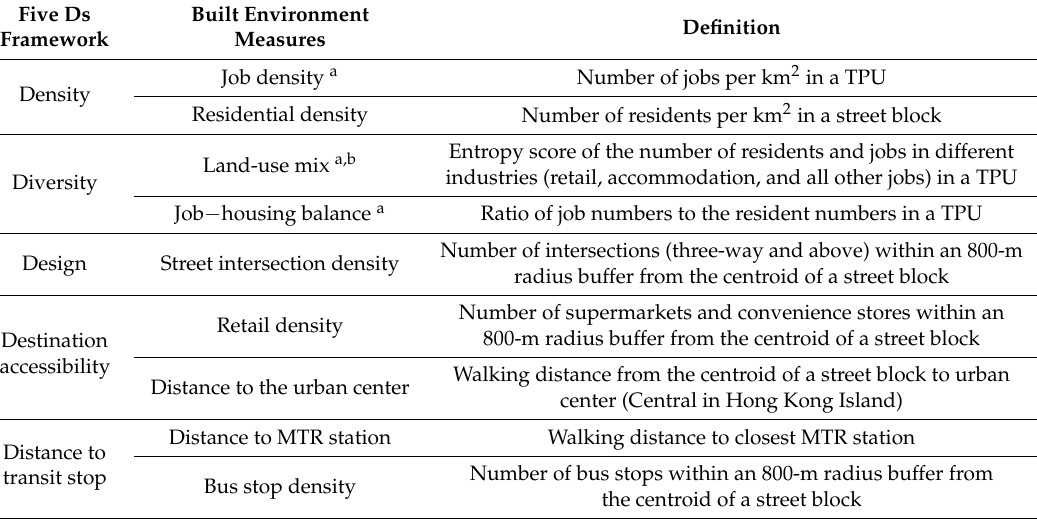
Table 1. Built environment